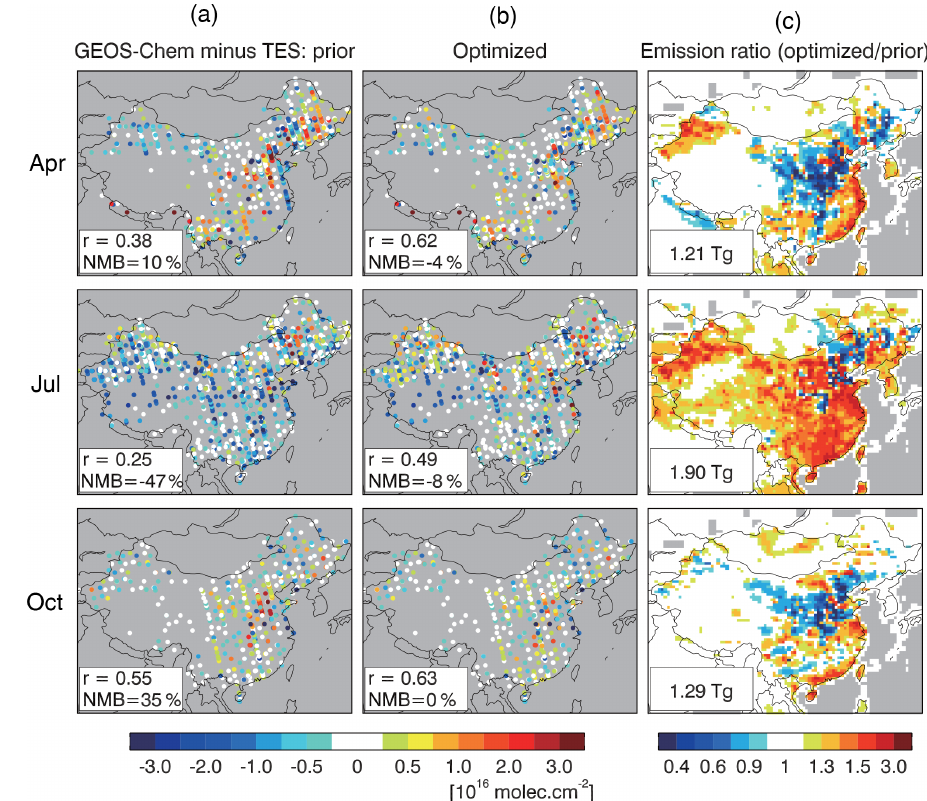
Figure 3. Differences between GEOS-Chem-simulated and TES-observed NH 3 column concentrations over China for April, July, and October. Panels (a, b) show results from model simulations with prior and optimized NH 3 emissions, respectively. Correlation coefficients ( r ) and normalized mean biases (NMB) are shown inset. Panel (c) shows monthly correction ratios relative to the prior emissions with optimized Chinese emission amounts shown